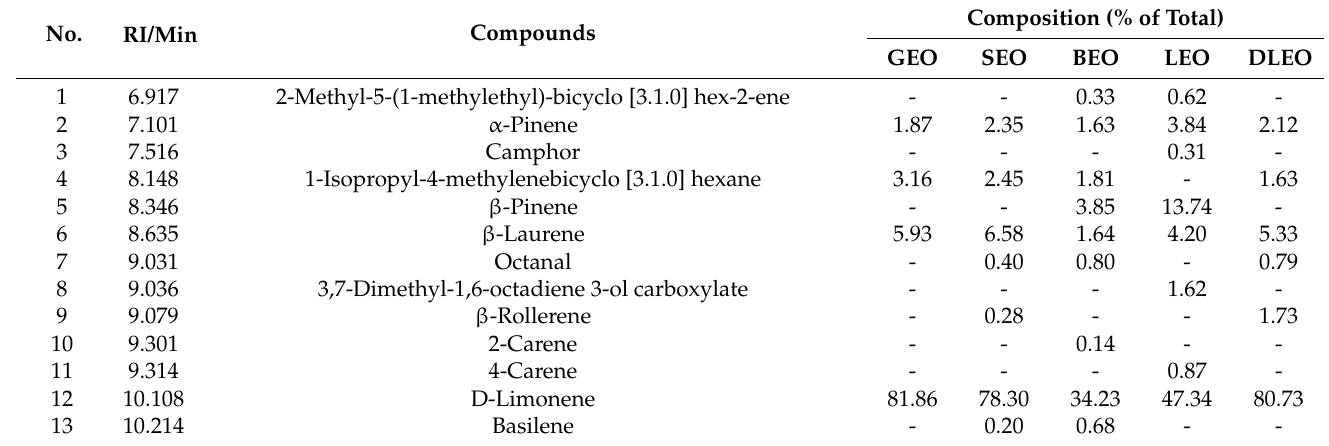
Table 1. Chemical composition profiles of 5 citrus